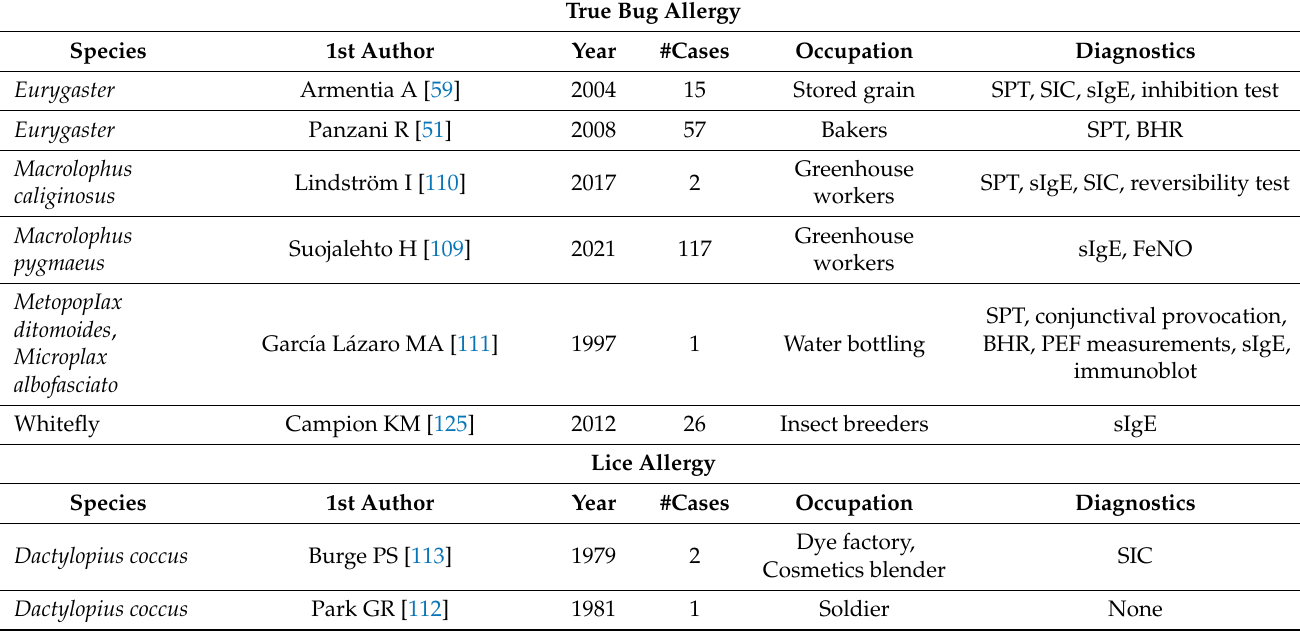
Table 6. Hemiptera